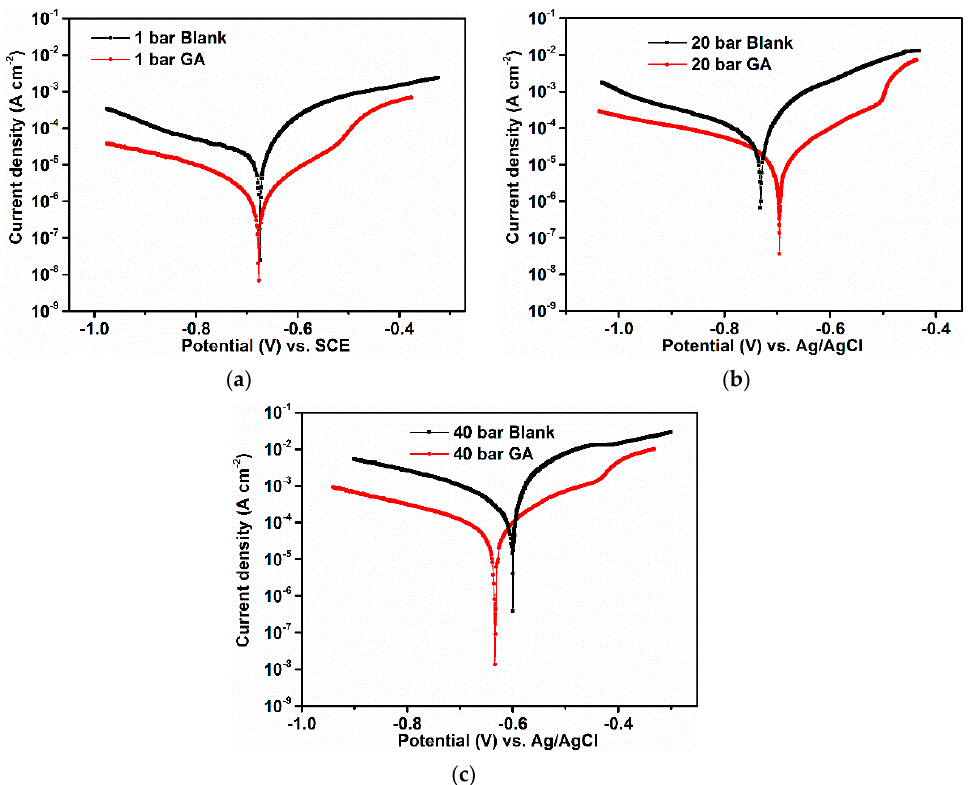
= 1 bar, ( b ) P = 20 bar = 1 bar, ( b ) P CO = 20 bar CO 2 2 2 2